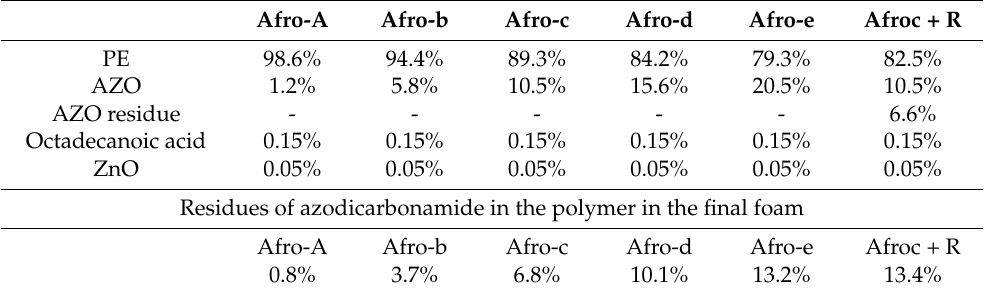
Table 1. Composition of the foam precursors and the final residues of azodicarbonamide disperser in the final foams. Afro-A Afro-b Afro-c Afro-d Afro-e Afroc + R